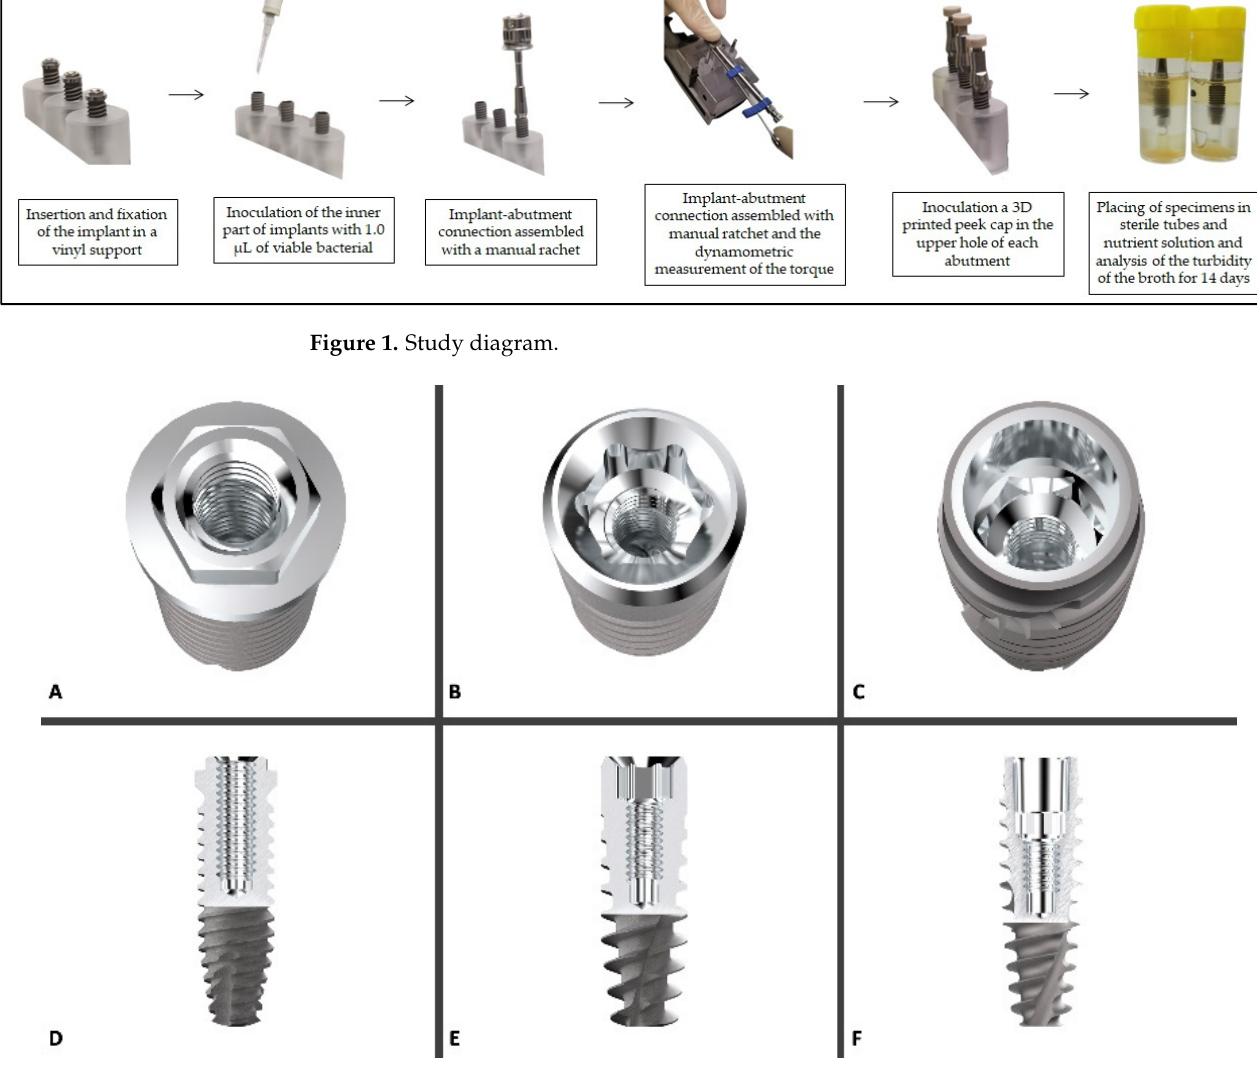
Figure 2. 3D rendering of the three implant platforms compared in this study (( A ) = External Hexagone, ( B ) = Internal Hexagone, ( C ) = Cone Morse), with the relative longitudinal section of the implant/abutment connection (( D ) = EH, ( E ) = IH, ( F ) = CM). Courtesy of AON (Grisignano di Zocco, Italy).